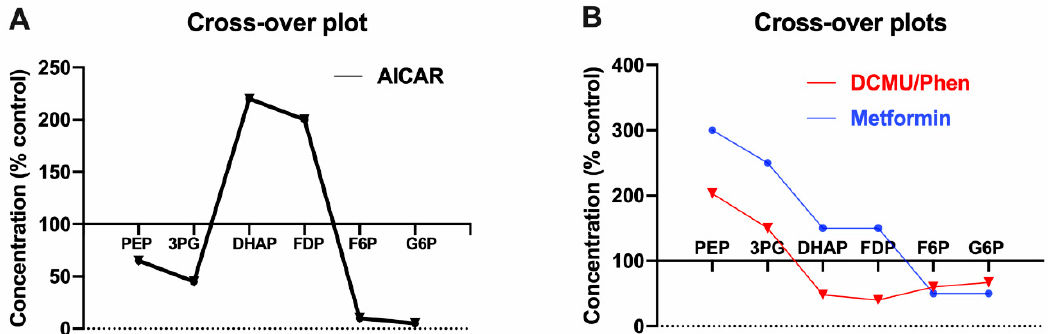
Figure 2. Crossover plots of metabolites of gluconeogenesis and glycolysis in liver or isolated hepatocytes. ( A ) Effects of AICAR (500 μ M) in hepatocytes incubated with 10 mM lactate + 1 mM pyruvate [61]. ( B ) Effects of mitochondrial inhibitors (DCMU, dichlorophenyl dimethylurea) [69] or phenformin [70], in rat hepatocytes incubated with 10 mM lactate + 1 mM pyruvate (red) or effects of metformin on rat liver in vivo [6] (blue).